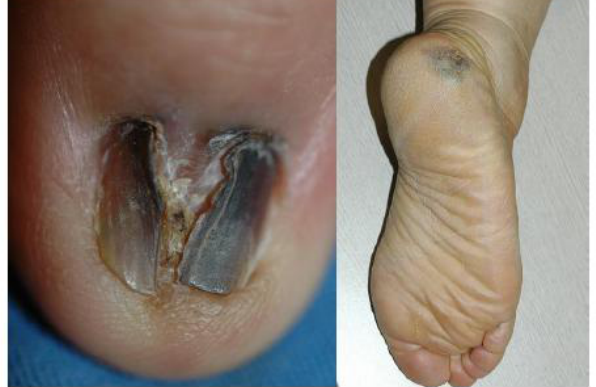
Figure 1. (A) Patient 4: black to brown colored pigmented patch on the left ring finger (B) Patient 7: irregularly pigmented patch on the right